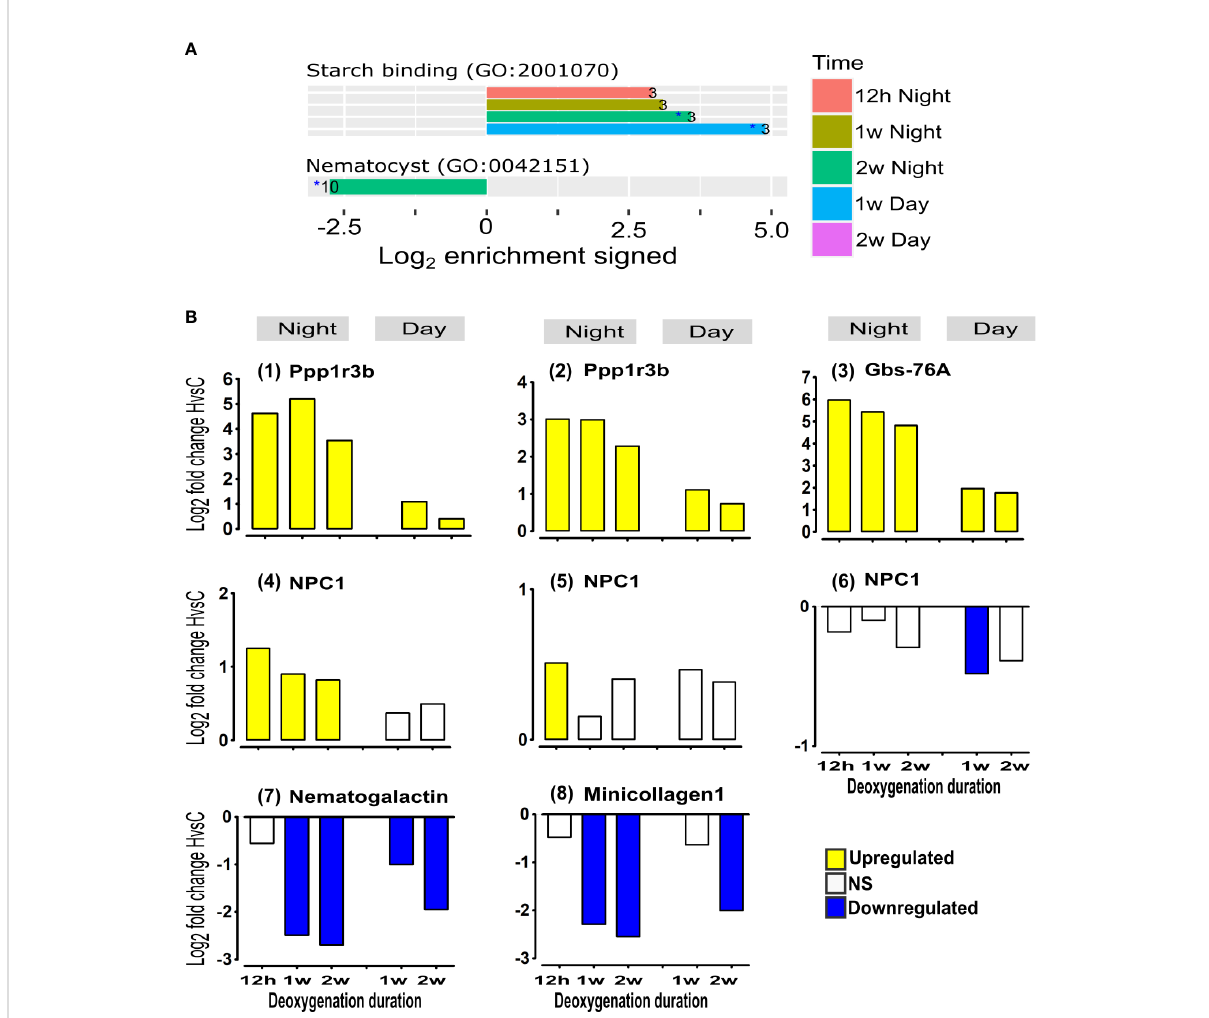
FIGURE 6 Acclimation to deoxygenation includes enhanced expression of starch/glycogen acquisition genes and reduction in the expression of nematocyst formation genes. (A) Selected functional groups of genes signi fi cantly overrepresented among H vs C DE genes. Enrichment log 2 fold changes represent the fraction of DE genes in foreground vs. background (see Methods). Positive/negative bars correspond to up/down regulated genes. Only overrepresentations with adjusted p -values<0.05 are shown. Numbers at the bars represent the count of DE genes for the category at the speci fi ed time point. (B) Starch/glycogen genes: (1), (2) Protein phosphatase 1 regulatory subunit 3B genes (Ppp1r3b) (Gene9265 and gene9266, respectively); (3) Glycogen-binding subunit 76A (Gbs-76A) (gene9264). Sterol genes: (4),(5),(6) Niemann-Pick C1 genes (NPC1) (gene18538, gene22242 and gene22241, respectively). Nematocyst formation genes: (7) Nematogalactin (gene23685); (8) Minicollagen1 (gene16439). DE ( p <0.05) of H vs C response is represented as Log 2 FoldChange. NS- not signi fi